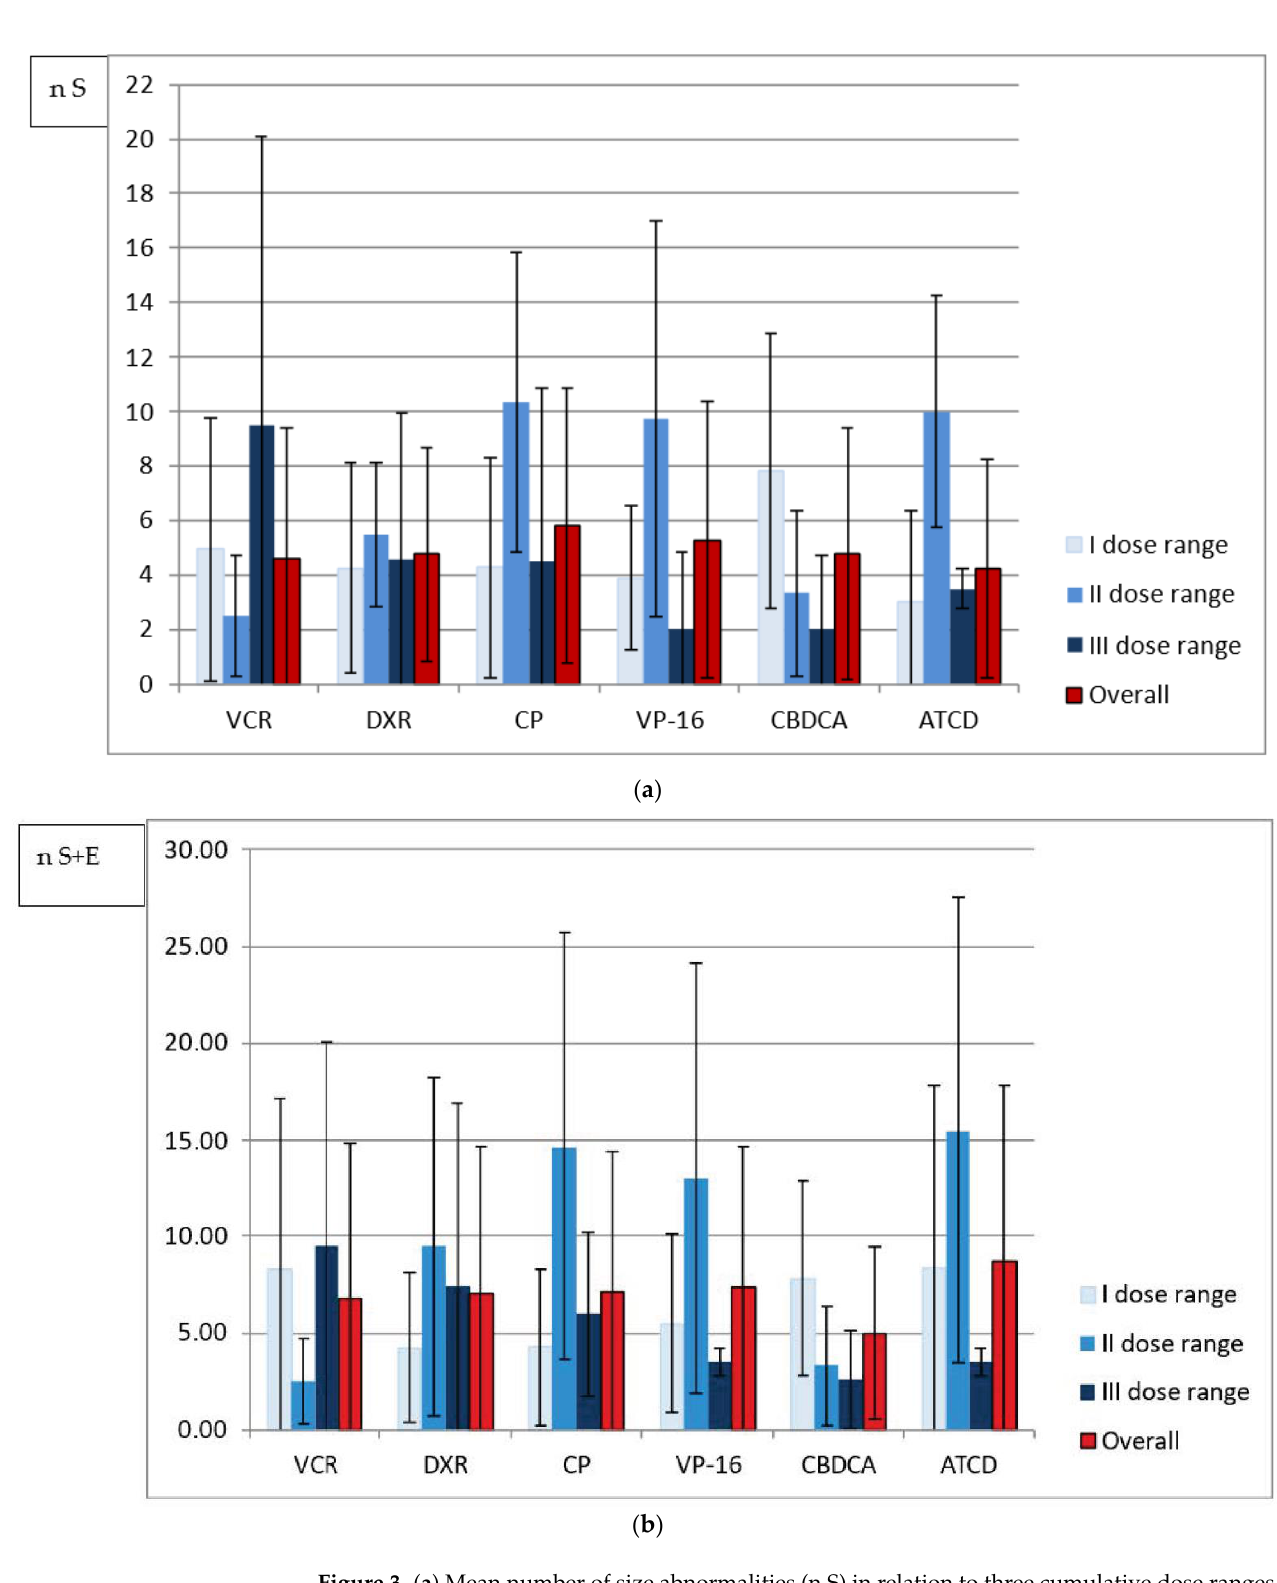
Figure 3. ( a ) Mean number of size abnormalities (n S) in relation to three cumulative dose ranges of analyzed drugs. ( b ) Mean number of all abnormalities (n S + E) in relation to three cumulative dose ranges of analyzed drugs.